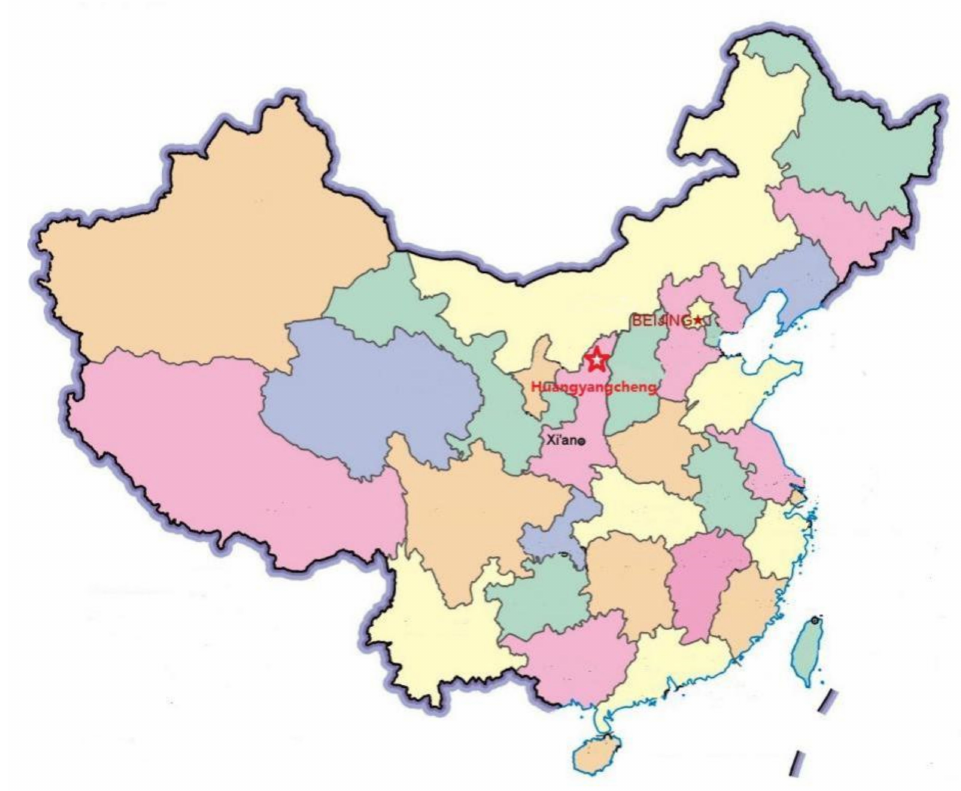
Figure 8. The location of Huangyangcheng station.